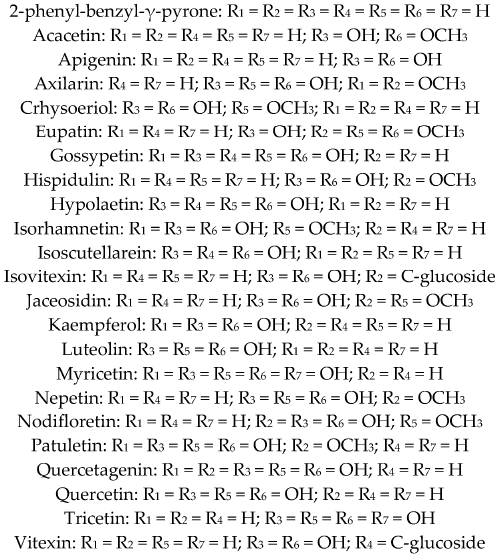
Figure 1. Flavonoid characteristic skeleton and known flavonoids.